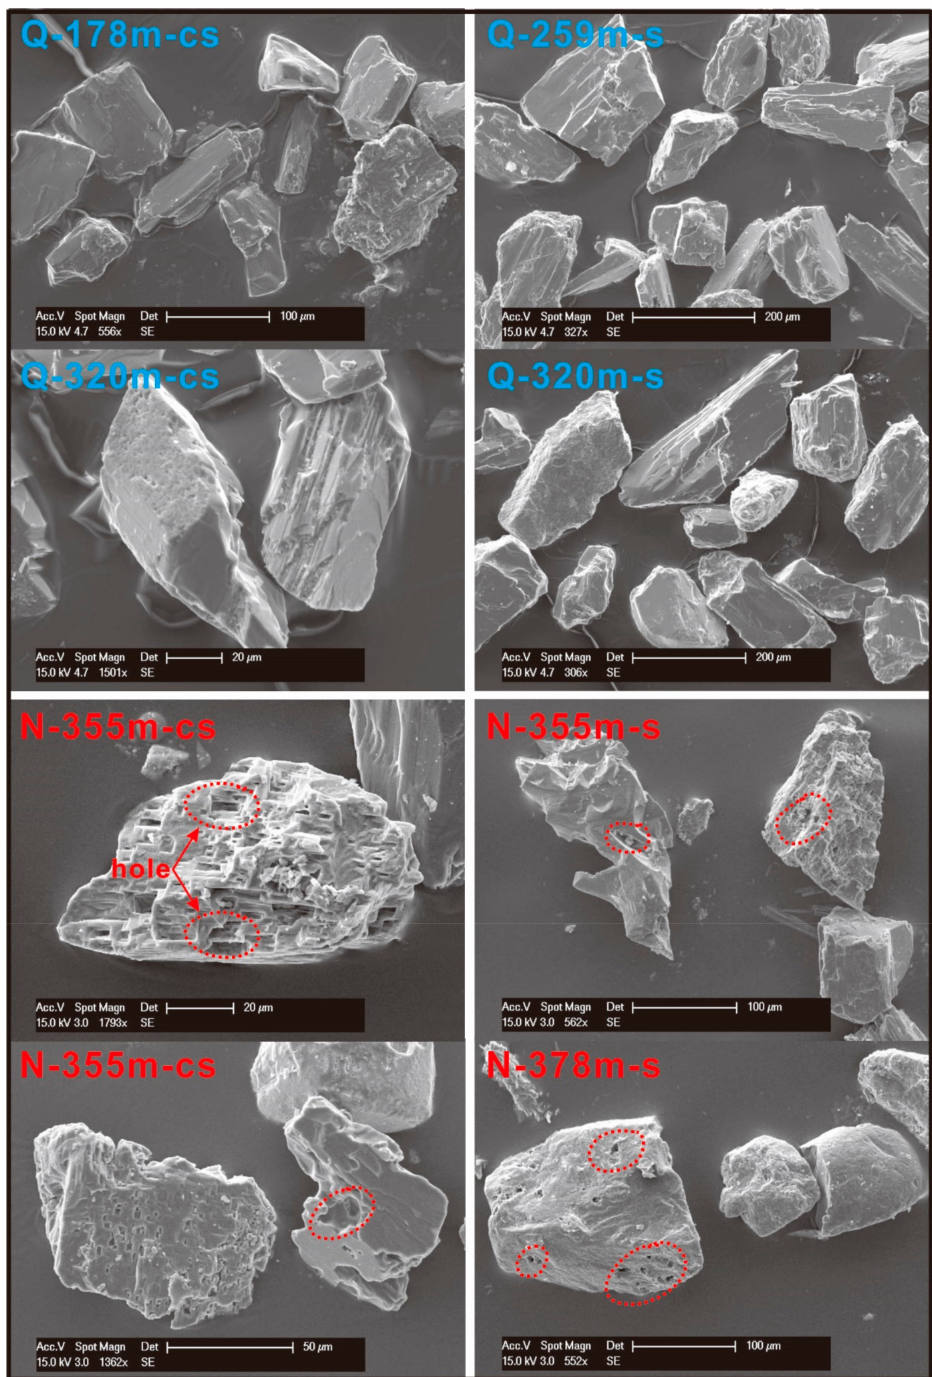
Figure 9. Surface texture of the amphibole in the Core LQ24 of the Changjiang Delta. s = Very fine sand fraction (63–125 µ m), cs = coarse silt fraction (32–63 µ m). N = Pliocene, Q = Pleistocene. Unlike the sample of the Pliocene strata, the surface texture of the unstable heavy minerals in the Pleistocene sample displayed di ff erent characteristics. Amphibole and epidote grains generally had an irregular-angular shape, and their crystal surfaces were relatively fresh (Figures 9 and 10). Two systems of cleavage were obvious at a specific angle. Only a few particles had a fuzzy crystal surface and plane due to dissolution and abrasion (Figures 9 and 10). The crystal morphology of the di ff erent grain size displayed little surface texture di ff erence between the very fine sand and coarse